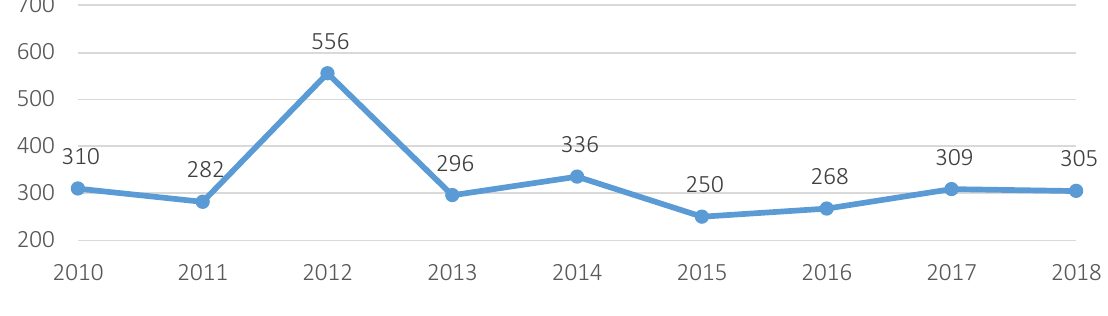
Figure 9. 4th class waste generation in Odesa region in 2010–2018, kg per 1 person